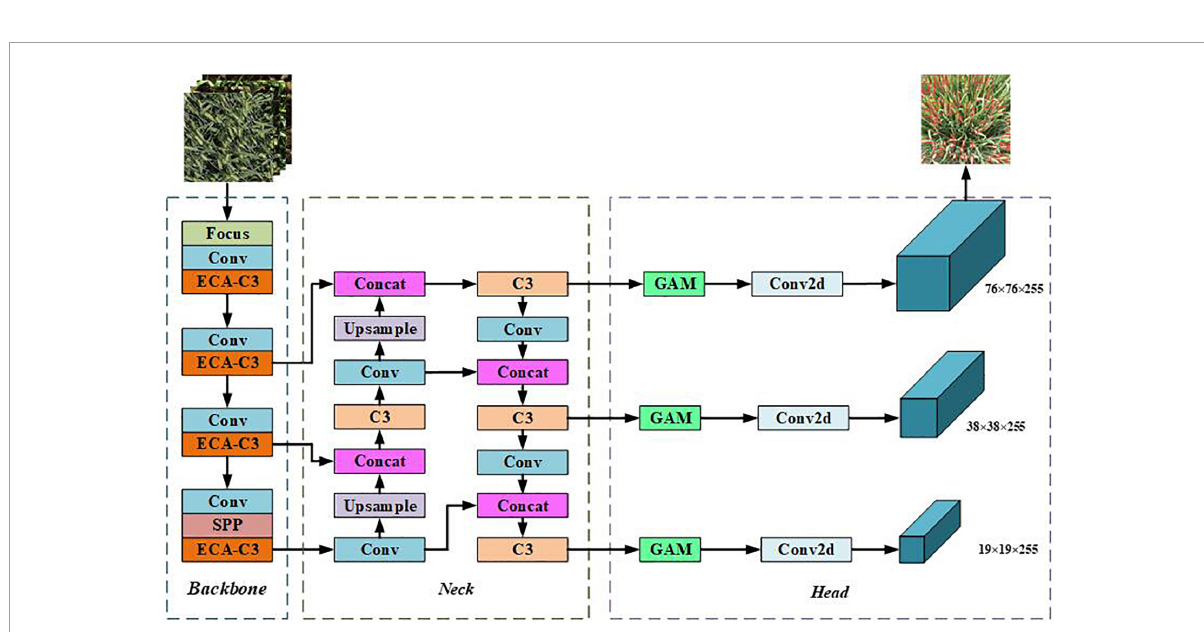
FIGURE7 Network structure of improved YOLOv5s